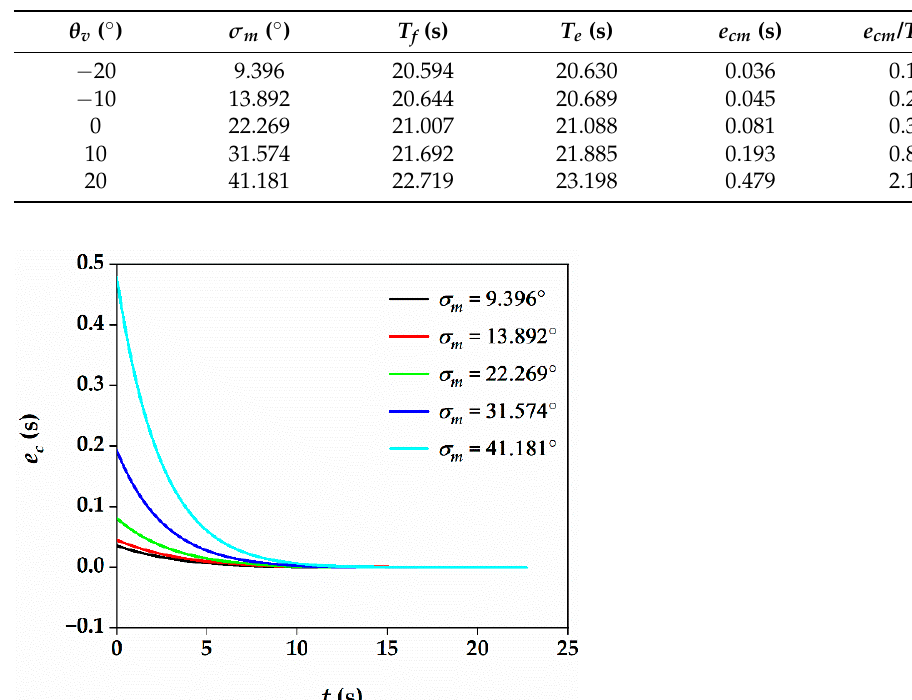
Table 3. Simulation results under different initial lead angles.